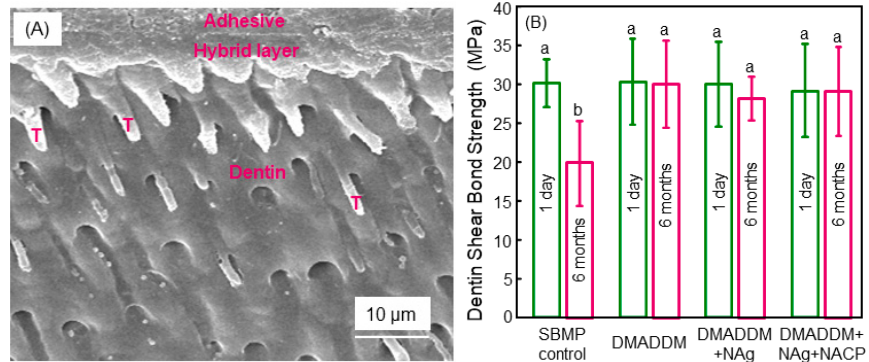
Figure 3. Dentin bonding. ( A ) Typical SEM image of the dentin–adhesive bonded region after one day of immersion. “T” indicates resin tags. (A) is for the DMADDM + Nag + NACP group; similar features were found in other groups. ( B ) Dentin bond strengths measured in shear (mean ± SD; n = 10). Values indicated by dissimilar letters are significantly different from each other ( p < 0.05). Water-aging